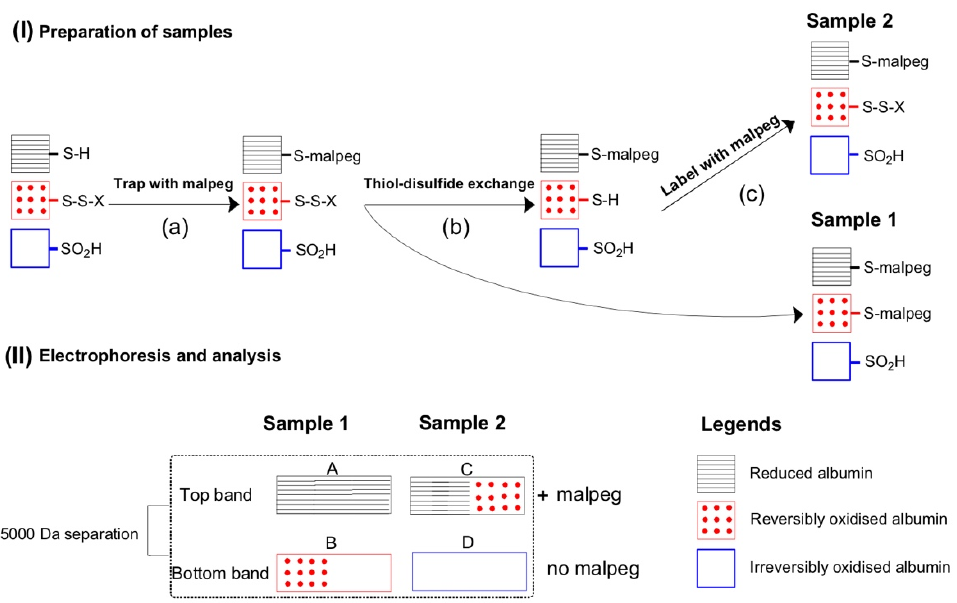
Figure 1. The measurement of irreversibly versus reversibly oxidized albumin Cys 34. ( a ) Represents available thiols (-S-H) in the plasma sample that are initially trapped with malpeg. ( b ) The sample is divided in two, with reversibly oxidised thiols (S-S-X) in the second sample converted to reduced thiols by thiol-disulphide exchange reactions and then ( c ) the reduced thiols are labelled with malpeg. Following electrophoresis, albumin bound to malpeg is separated by 5000 Da figure.